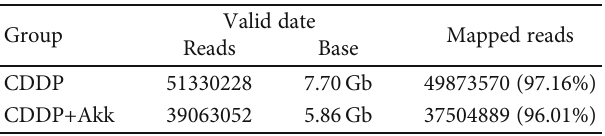
Figure 2: E ff ect of CDDP combined with Akk on tumor pathology in lung cancer mice. The pathological picture of the model control group (a), the CDDP group (b), the CDDP+Akk group (c), and the CDDP ABx group (d). Lung tissues were fi xed, stained with H&E solution, and observed under a microscope of 400 magni fi cations. Table 3: Sequence alignment statistical results between the sample sequencing data and the selected reference